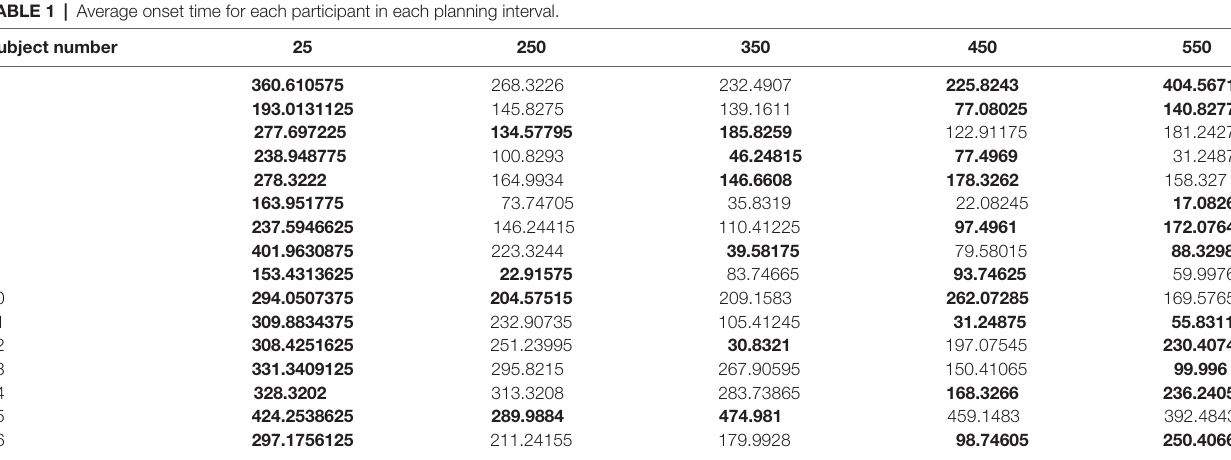
TABLE 1 | Average onset time for each participant in each planning